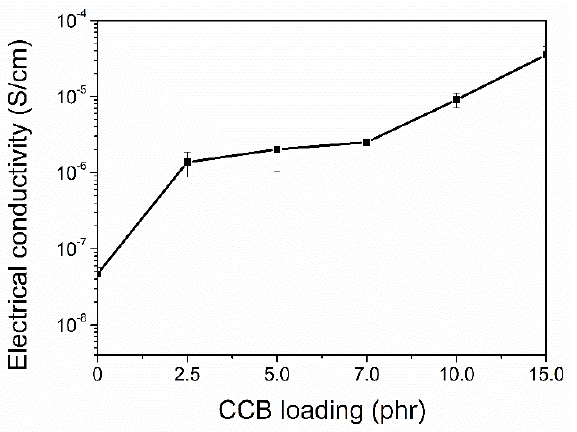
Figure 9. Electrical conductivity as a function of frequency of ENR ‐ FeCl 3 filled with CNTs (F7 ‐ CNT7) and CNT ‐ CCB hybrid filler with various CCB loadings at 2.5, 5.0, 7.0, 10.0 and 15.0 phr.